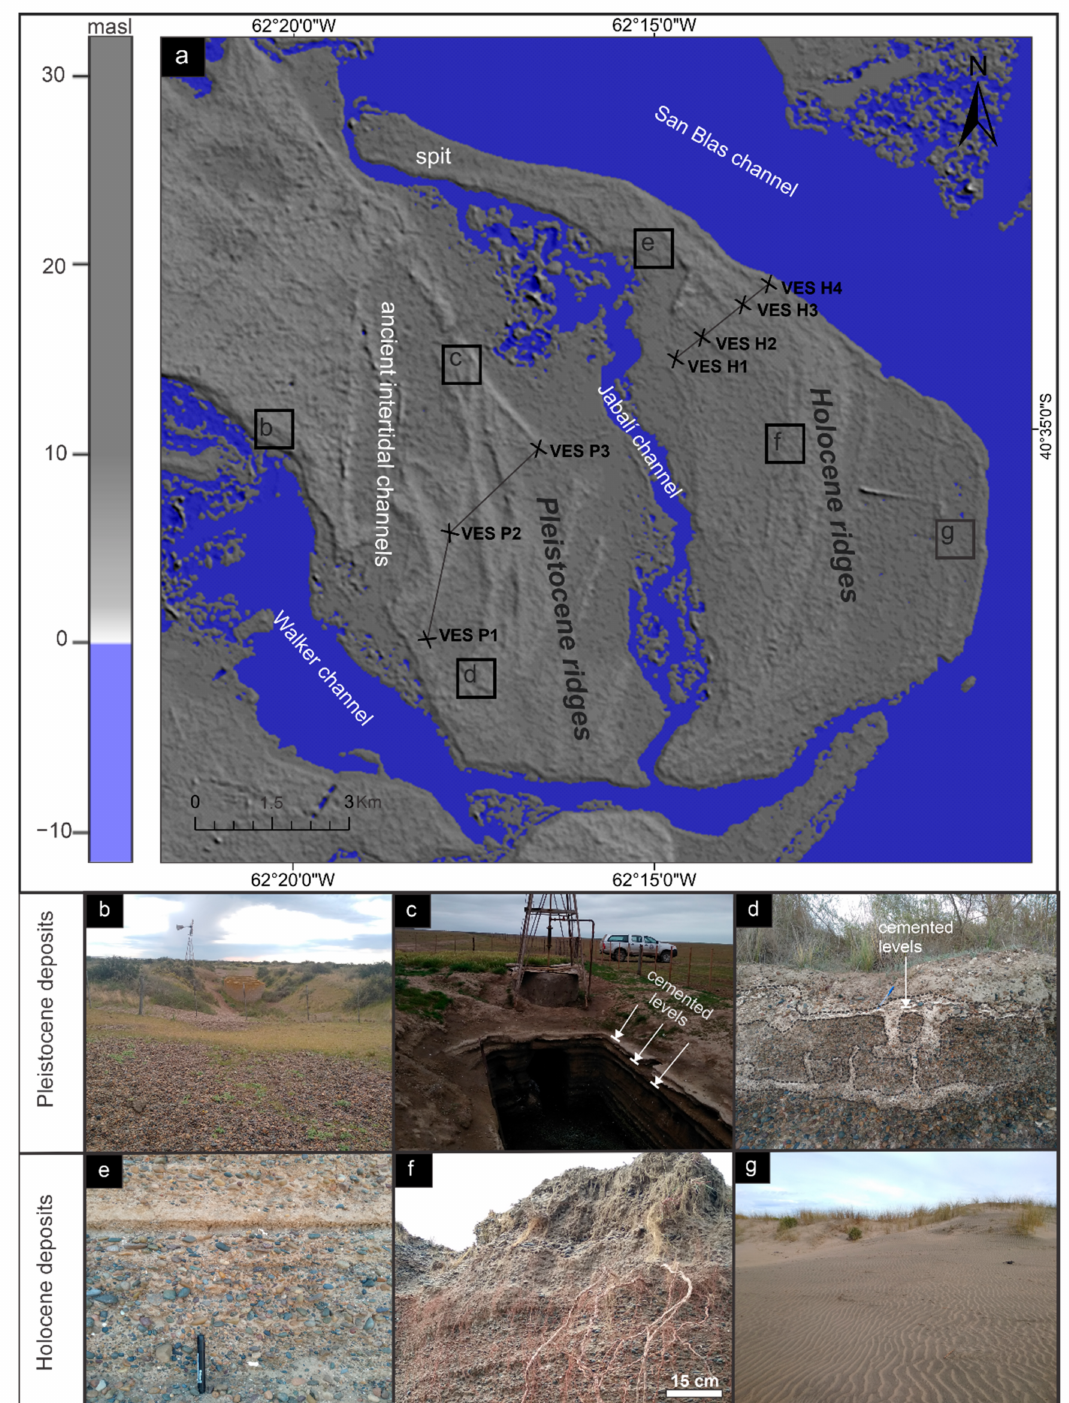
Figure 2. ( a ) Digital elevation model where the disposition of Pleistocene and Holocene beach ridges is indicated; ( b ) Pleistocene beach ridges with groundwater catchments; ( c ) groundwater catchment well where cemented levels are observed within Pleistocene deposits; ( d ) ground section where the cemented levels are observed within the Pleistocene deposits; ( e , f ) Holocene stratified gravel deposits with different percentages of the sandy matrix; ( g ) Holocene deposit of